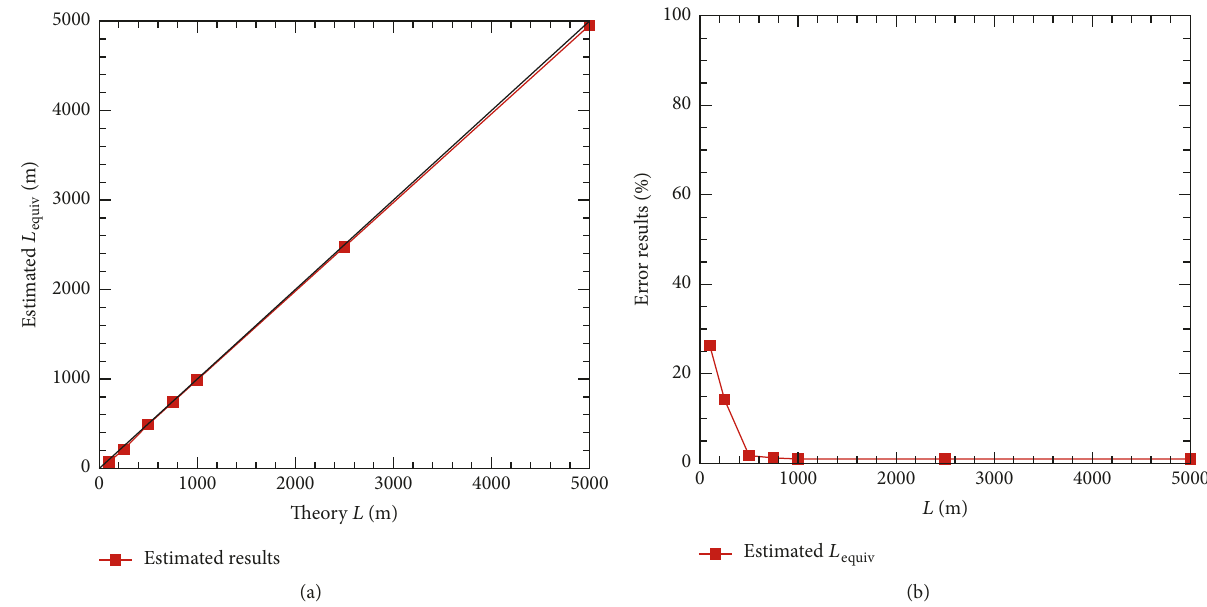
Figure 5: Results of 1D aquifer of the (a) scatter plot of the theory 𝐿 versus the estimated 𝐿